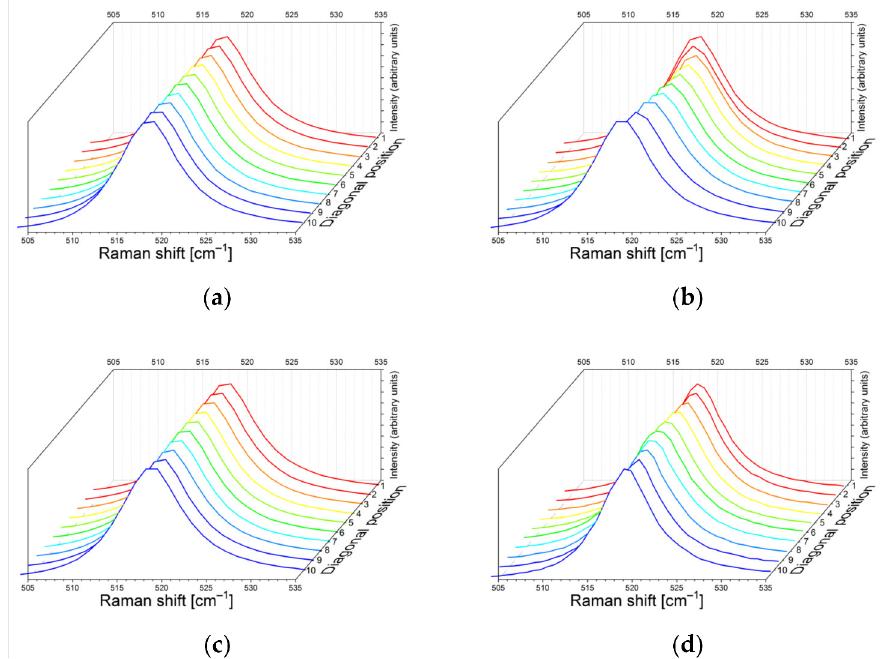
Figure 6. Raman peak, corresponding to the LO phonon mode, collected, at room temperature, along the diagonal points (from [1, 1] to [10, 10] of Figure 4b) of ( a ) the Si_Unmounted chip, ( b ) sample A_AuSn, ( c ) sample A_AuSn_p and ( d ) sample B_AuSn.